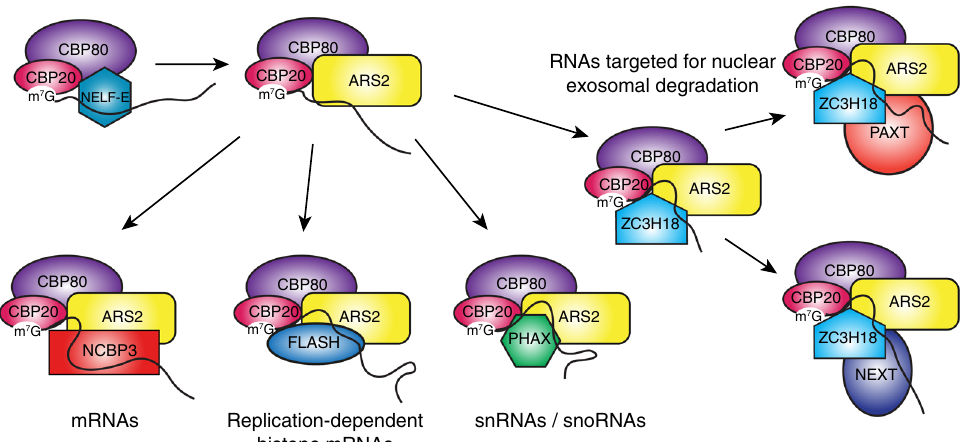
Fig. 7 Mutually exclusive CBC – ARS2 complexes. Schematic diagram showing model of mutually exclusive CBC and CBC – ARS2 complexes identi fi ed in this work or by others (see text). Early in transcription CBC is proposed to bind to NELF-E which is subsequently replaced by ARS2 24 . Then, depending on the type of RNA and the corresponding 3 ′ end processing and export pathways, alternative and mutually exclusive CBC – ARS2 complexes assemble.